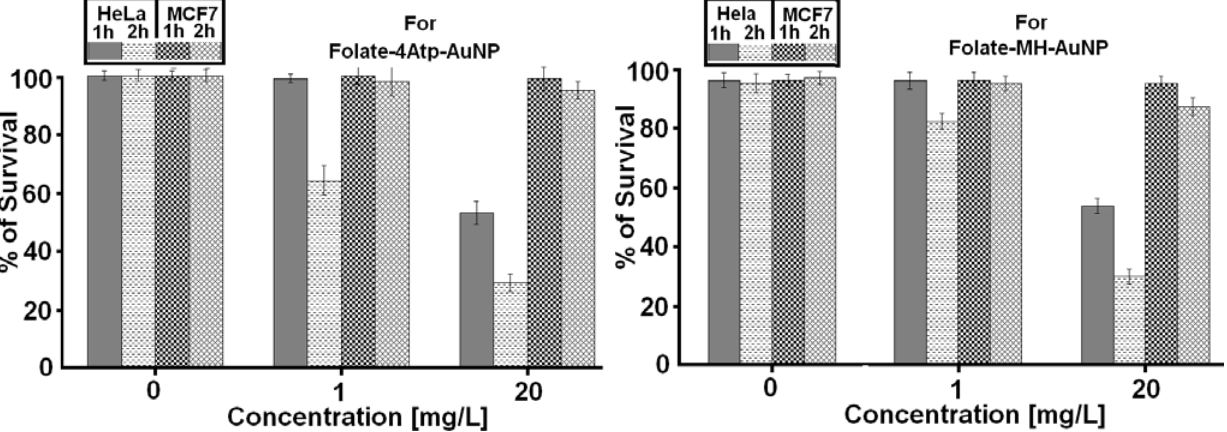
Figure 12. The percentage of HeLa and MCF7 cell survival following photothermal treatment versus Folate-4Atp-AuNP [25,26] and Folate-MH-AuNP nonoconjugates concentrations and with 1 and 2 h incubation